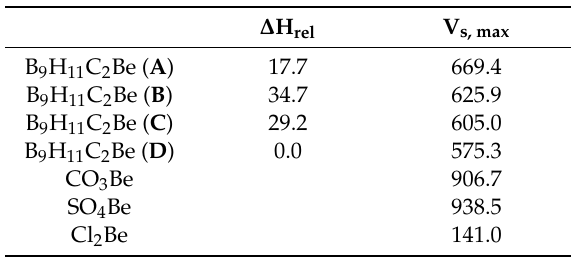
Table 1. Relative enthalpies, ∆ H rel (kJ · mol –1 ), of the four isomers of B 9 H 11 C 2 Be, with respect to